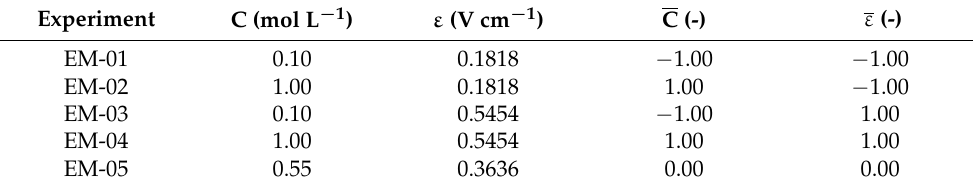
Table 2. The physical and coded configurations of the electromining experiments in the synthetic soil. Experiment